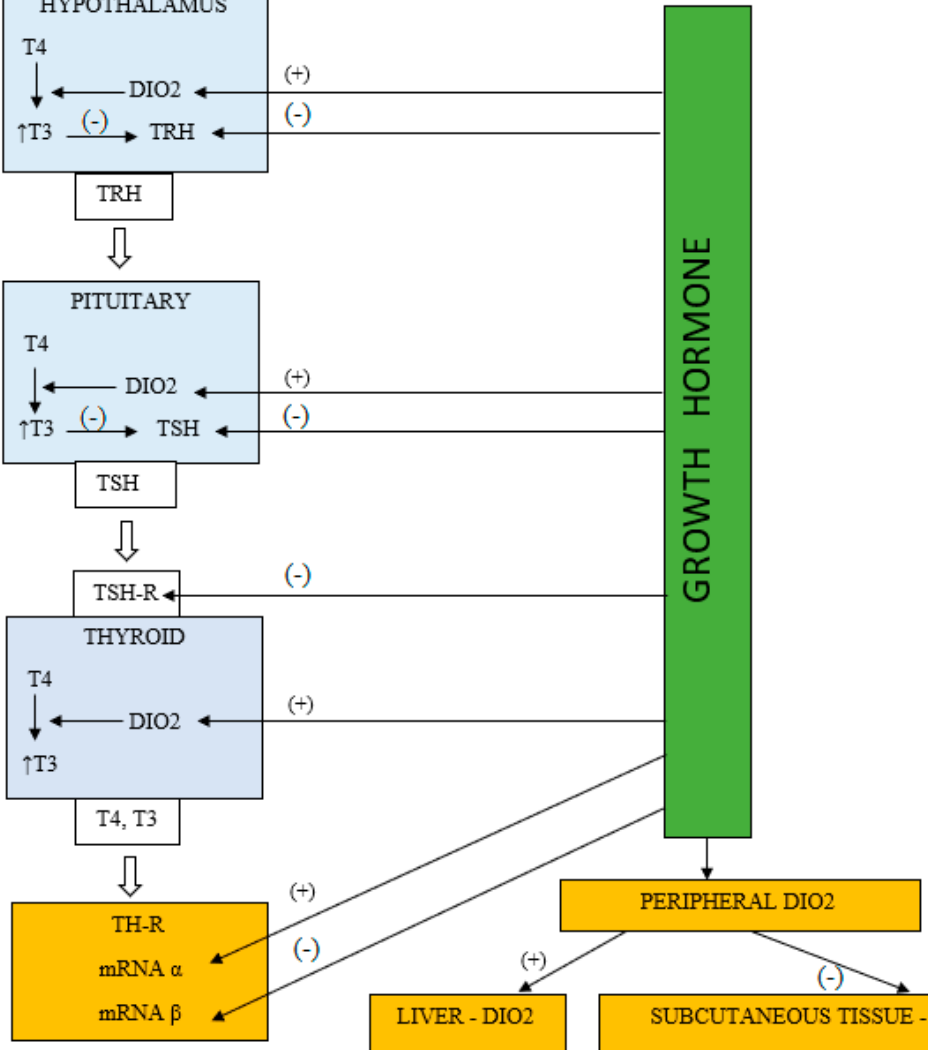
Figure 1. Hypothetic pathways of direct modulation of the hypothalamic-pituitary-thyroid receptors axis by growth hormone. TH-R—thyroid hormone receptor, DIO2—deiodinase 2, fT4—free thyroxine, fT3—free triiodothyronine, TSH— thyroid-stimulating hormone, TRH—thyrotropin-releasing hormone. 4. Therapeutic Implications of the rhGH Influence on Thyroid Function The unsolved issue is the indication for the L-thyroxine substitution in the patients treated with rhGH. Only a few patients develop overt hypothyroidism, but there is clinical evidence of the positive impact of higher thyroxine levels on growth velocity in children treated with rhGH [62]. Thyroxine enhances the effect of GH, directly stimulating the growth hormone receptor (GHR)/Janus kinase 2 (JAK2)/signal transducer and the activa- tor of the transcription 5 (STAT5) pathway [62], and therefore improves the growth effect during rhGH treatment. The regular monitoring of thyroid function is recommended in patients treated with rhGH [63]. On the other hand, there are some different opinions. Giavoli et al. [14], based on a group of children with GHD, both idiopathic isolated GHD